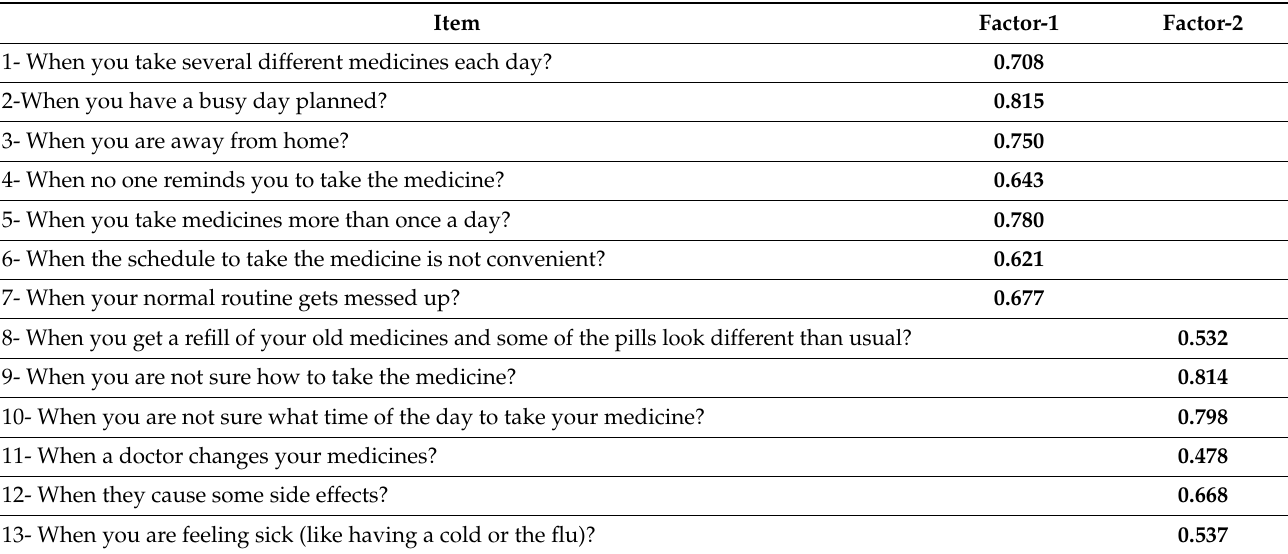
Table 3. Factor Analysis of the 13-item Arabic-SEAMS (Varimax rotation method). Item